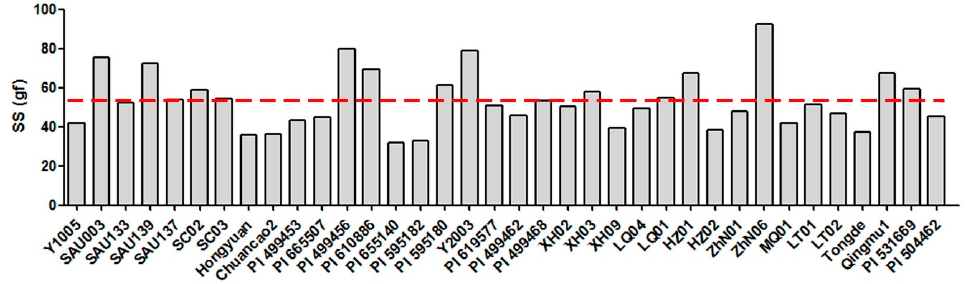
Figure 1. Seed shattering degree (SS) of 36 E. sibiricus accessions. The red dotted line represents the average value of seed shattering.